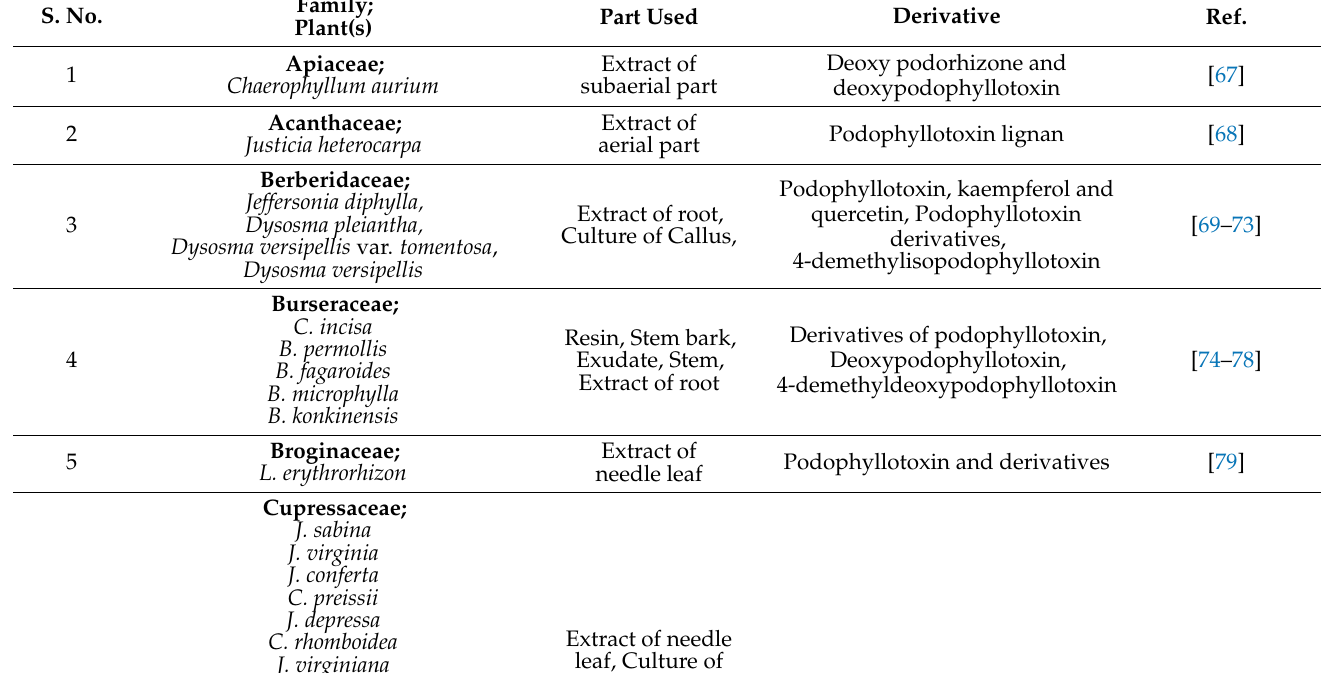
Table 1. Various plants from different plant families, which are well reported as sources of podophyllotoxin. S.